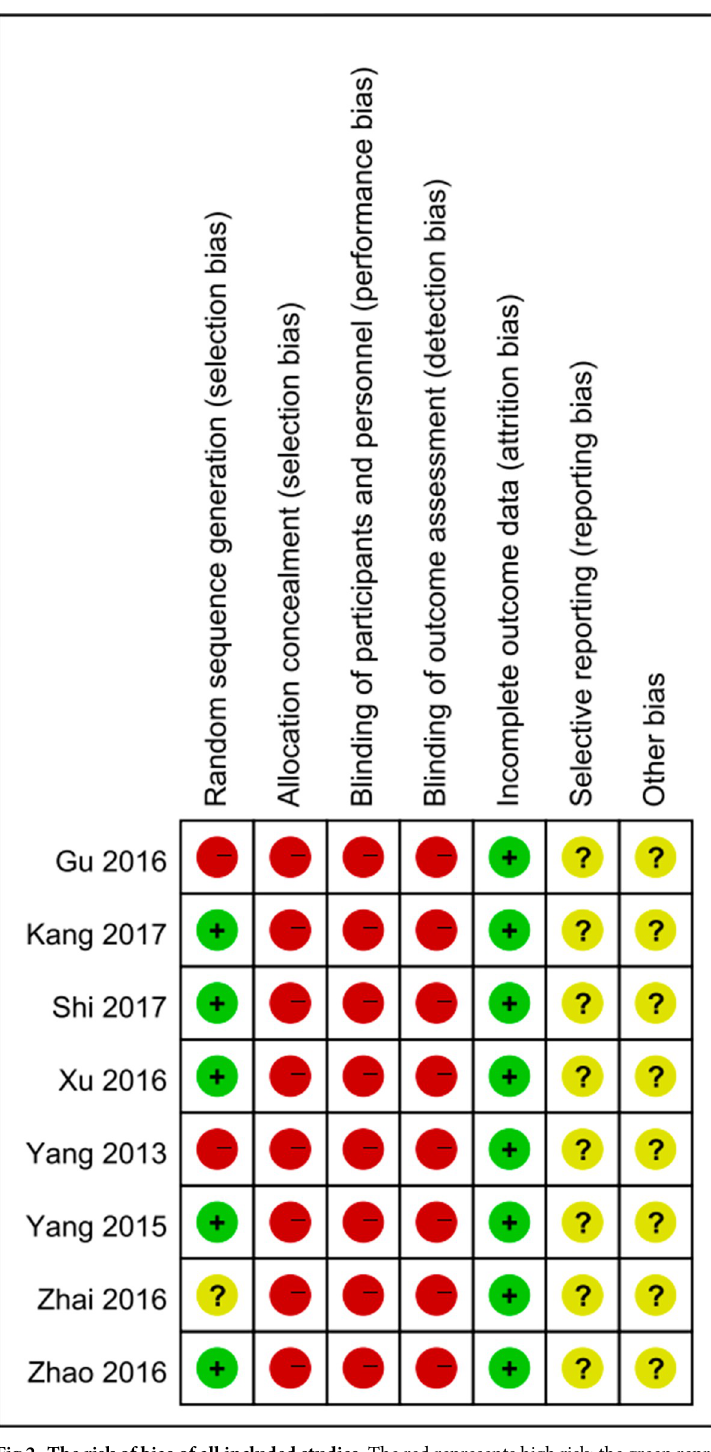
PLOS ONE | https://doi.org/10.1371/journal.pone.0268819 June 1,